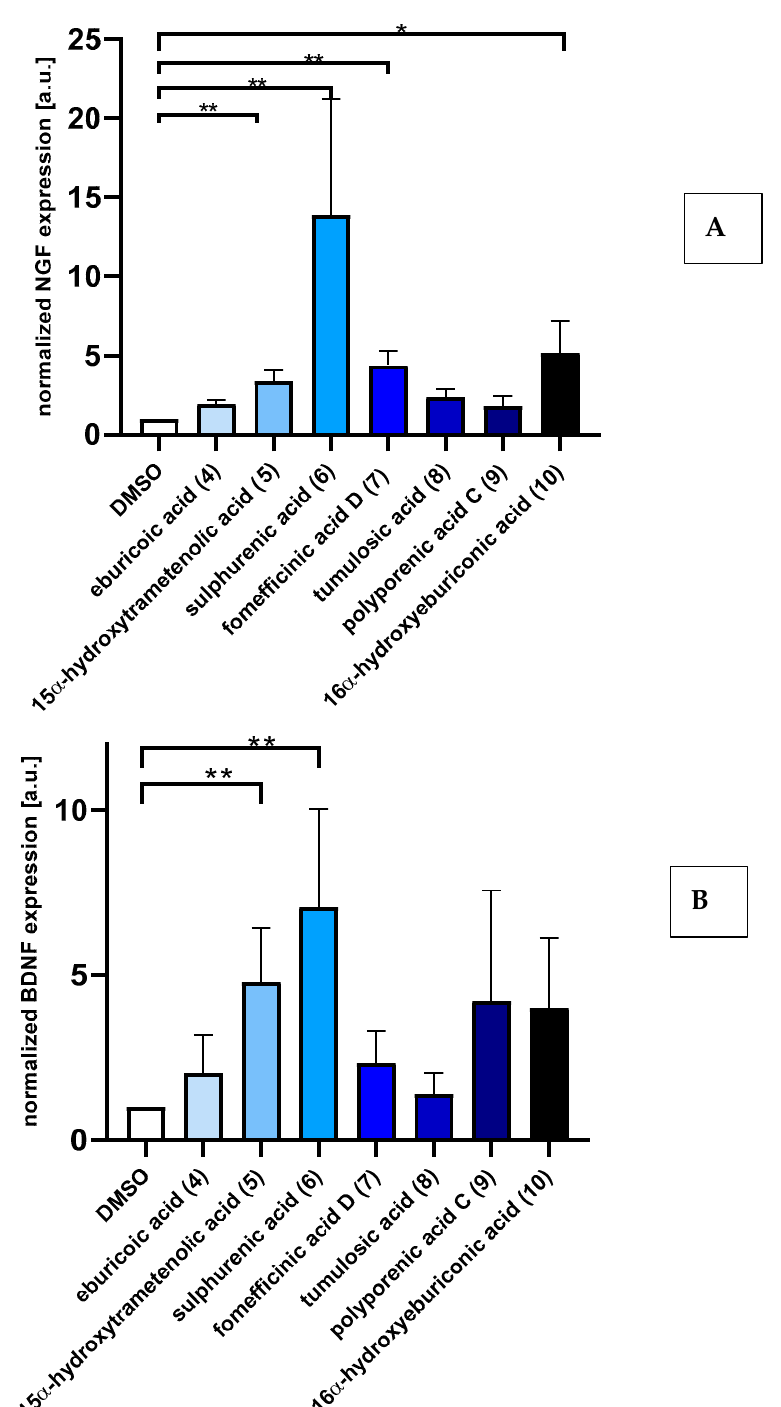
Figure 2. Triterpenoids induce both ngf and bdnf expression levels in 1321N1 astrocytoma cells. ( A ) and ( B ) Quantitative RT-PCR to compare the relative expression levels of ngf and bdnf in 1312N1 cells under triterpenes (5 µg/mL) and 0.5% DMSO treatment for 48 h. Data shown as bar graphs are means ± S.E.M.; n = 3 to 5 independent experiments. * p < 0.05, ** p < 0.01, Mann–Whitney rank sum test.